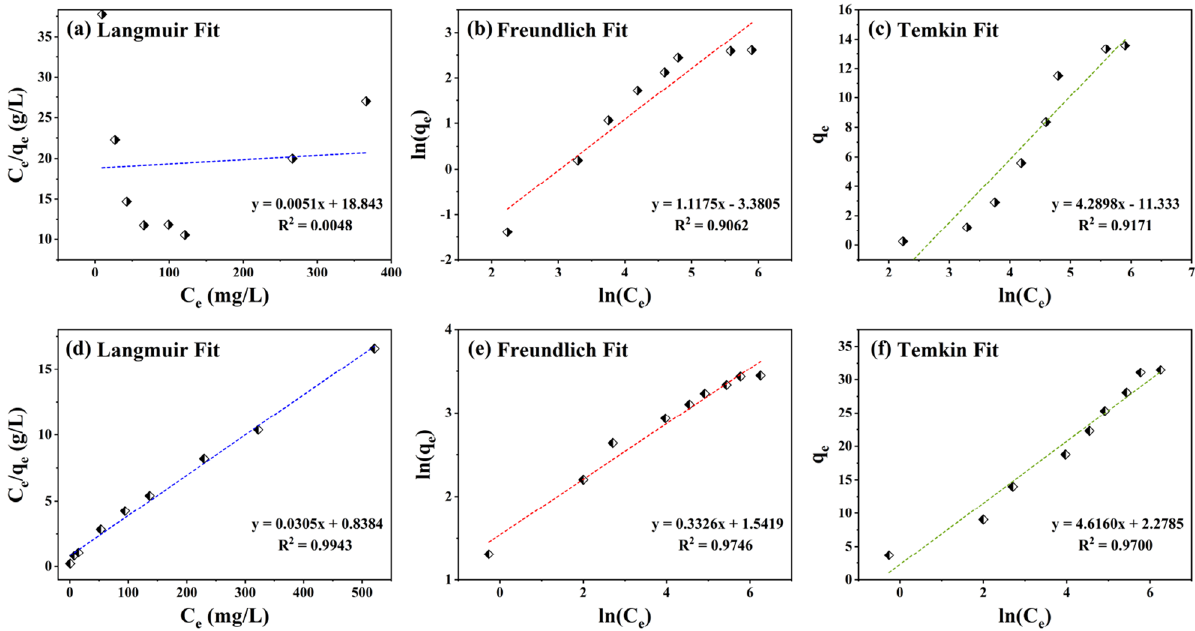
Figure 8. Linear fitting graphs of Langmuir ( a ), Freundlich ( b ) and Temkin ( c ) equations for HNTs adsorption of anionic dyes. And Linear fitting graphs of Langmuir ( d ), Freundlich ( e ) and Temkin ( f ) equations for ChNTs adsorption of anionic dyes.